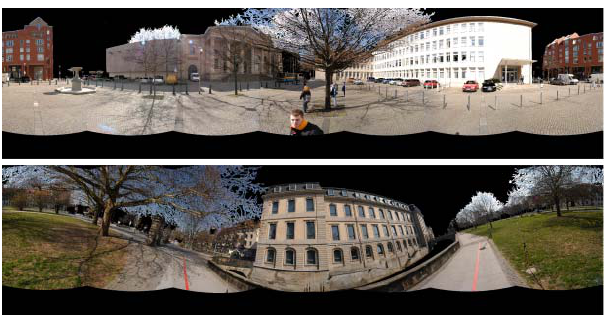
Figure 9. The RGB channel